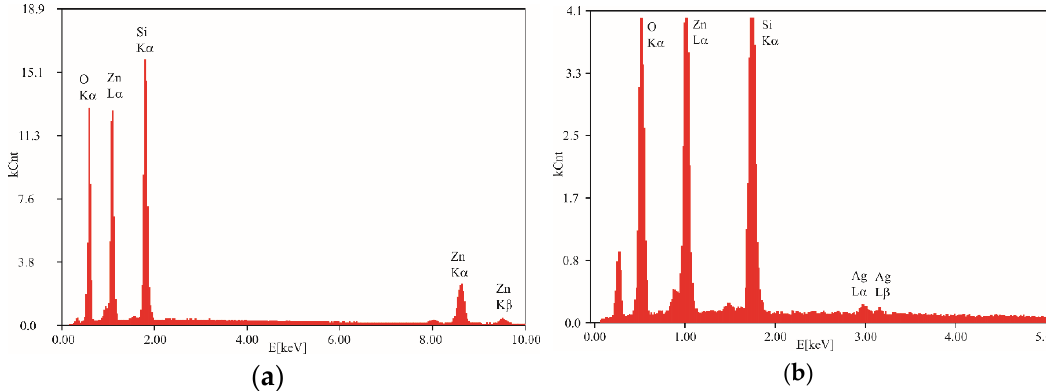
Figure 3. EDX qualitative analysis of: ( a ) silicate substrate ZnO· m SiO 2 and ( b ) final antimicrobial material Ag-ZnO · m SiO 2 . Unlabelled peaks have origin in supportive aluminium pad with carbon tape.